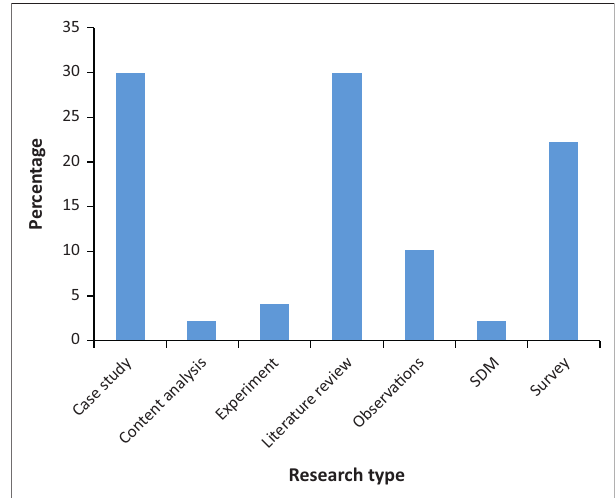
FIGURE 5: Articles by